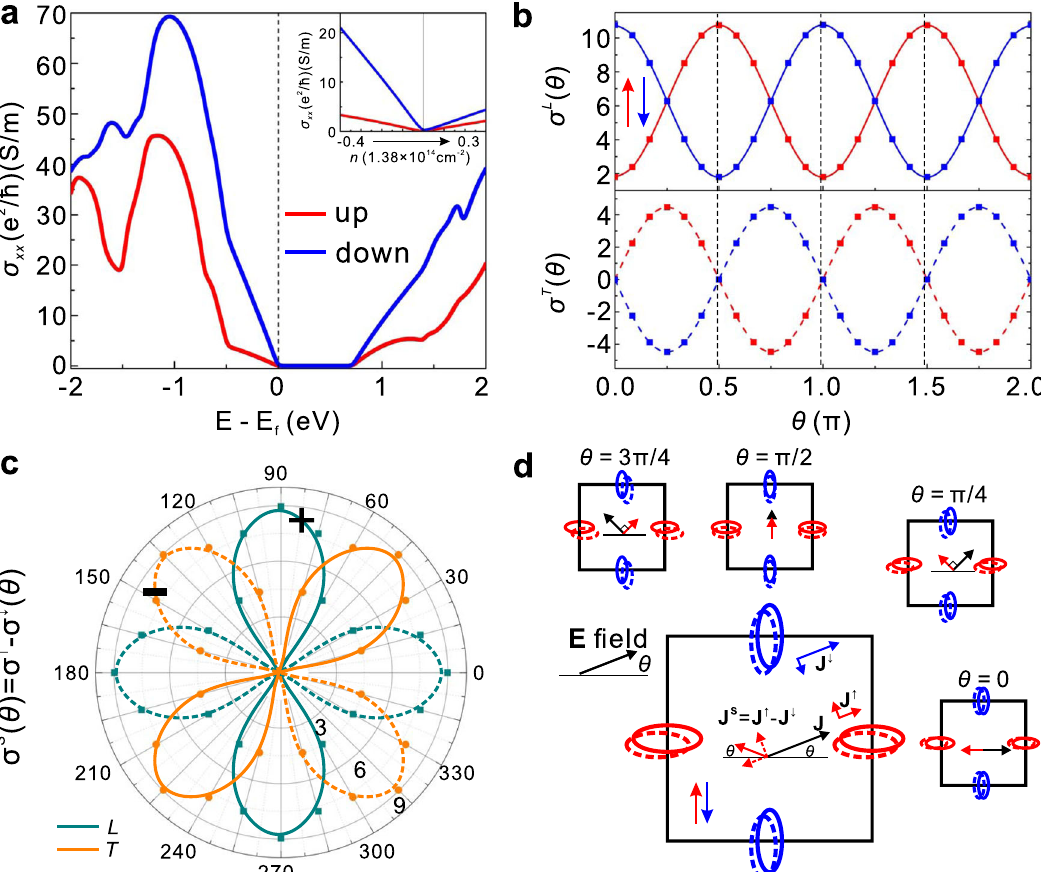
Fig. 4 Angle-dependent spin current and spin Hall effect in monolayer V 2 Se 2 O. a Spin-resolved charge conductivity σ for electric fi eld along x direction. Inset is the dependency of σ on the carrier density n . For light doping, σ increases almost linearly with n . b Angle-dependence of the longitudinal ( L ) and transverse ( T ) charge conductivity varying with the electric fi eld direction θ , taken at 0.2 eV below the valance band maximum. The transverse charge conductivity is always opposite for spin-up and spin-down electrons, and hence the transverse charge current is always zero and the charge current direction is always θ . c The corresponding angle-dependence of the longitudinal and transverse spin conductivity. d Relation between directions of charge current J and spin current J S . The spin current always fl ows along the direction π (cid:2) θ . In details, for θ ¼ ± π = 2, the spin current will be along the same direction of the charge current, whereas for θ ¼ 0 or π , the spin current fl ow along the opposite direction of the charge current. Moreover, for θ ¼ ± π = 4 or ± 3 π = 4, there will be large spin Hall effect, where the spin current is perpendicular to the charge